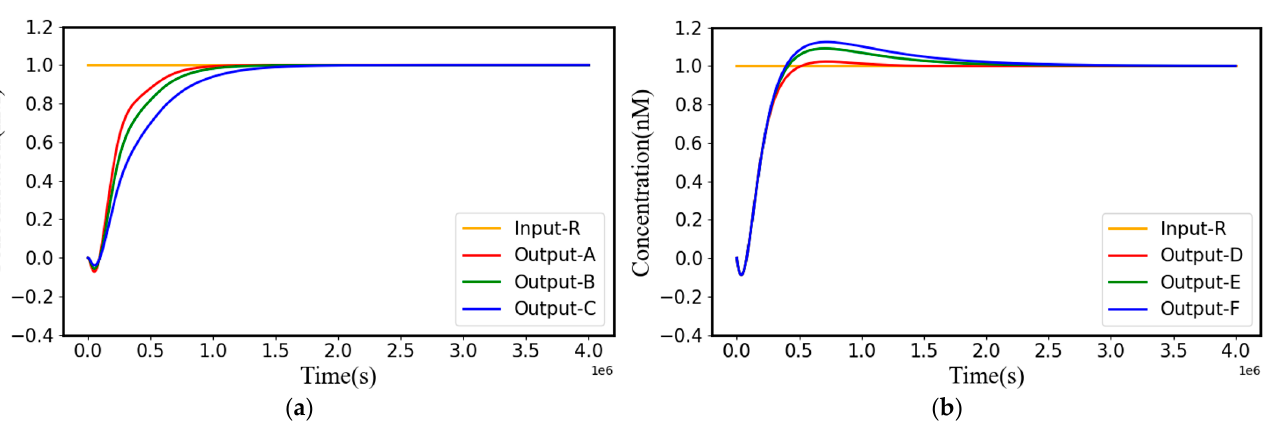
Table 4. Effect of filtering parameter λ 1 on controller set-point tracking performance.